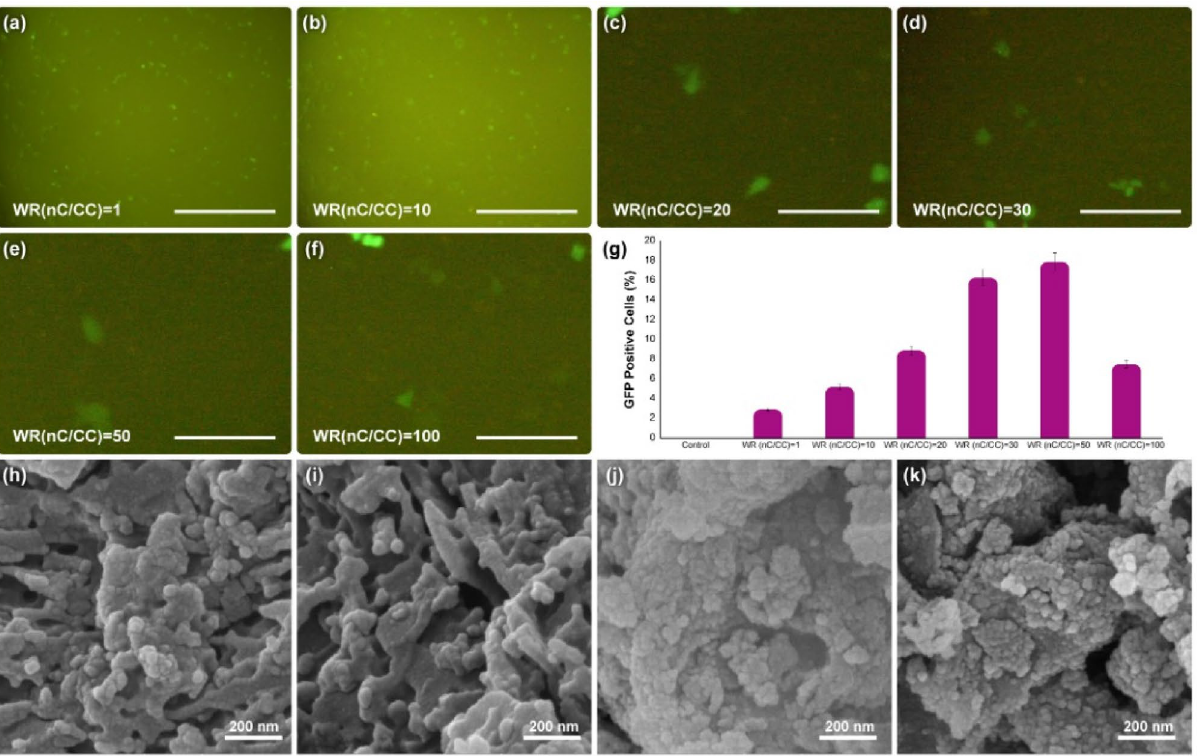
Figure 7. The results of ( a – f ) 2D fluorescence microscopy, and ( g ) GFP positive cells for the synthesized nanocomposite at different WR’s of nanocomposite (nC)/CRISPR/Cas9 (CC) on HEK-293 cell line. The data indicate the 2D fluorescence microscopy and EGFP read are presented as the mean (± SD) from three independent experiments. The Scale bar of ( a , b ) is 50 µm, and for ( c – f ) is 10 µm. The normal ( h – i )